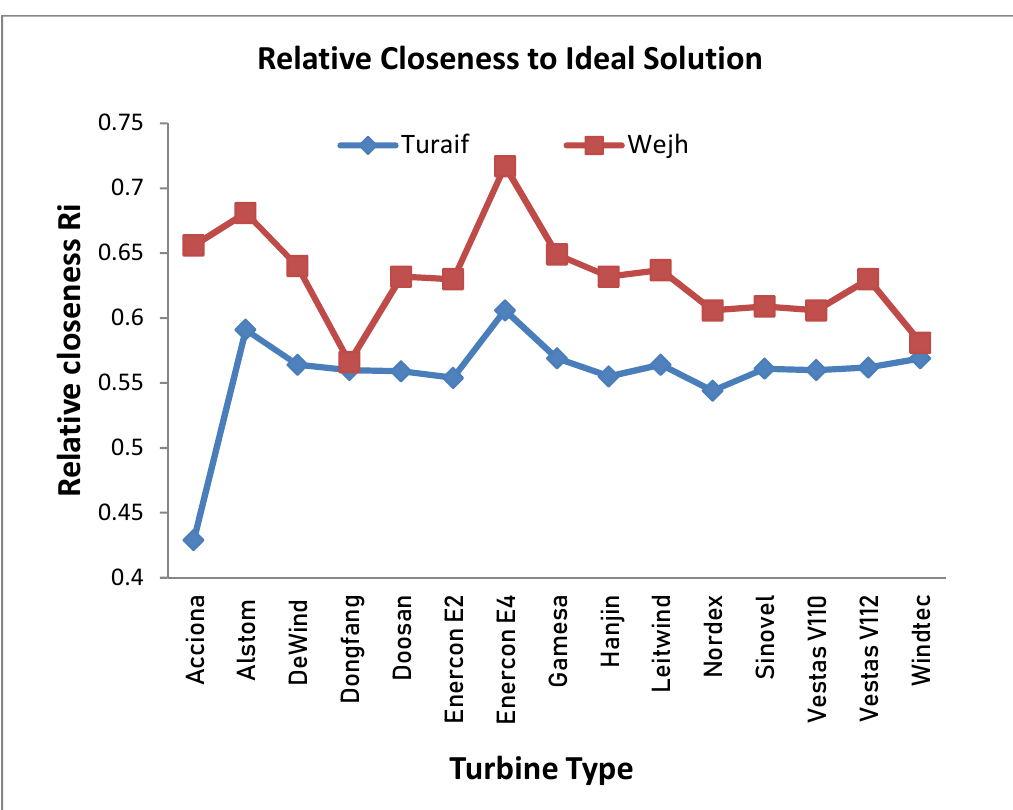
Figure 6. Comparison of R i for different turbines for Turaif and